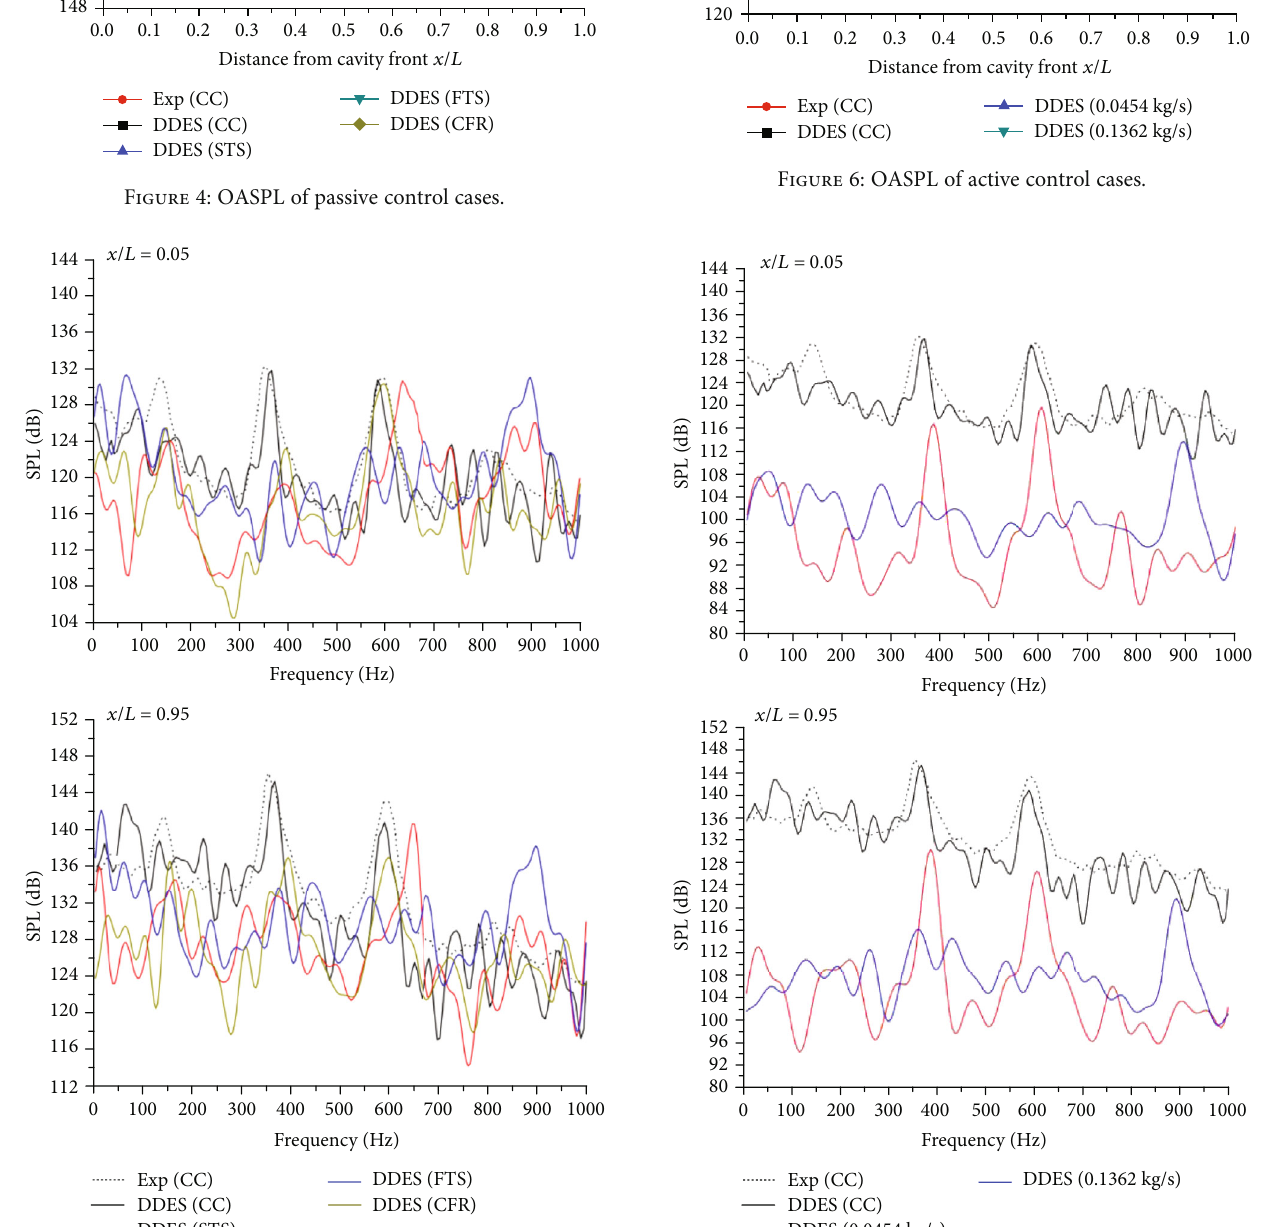
Figure 7: Sound pressure level at x / L = 0 : 05 and